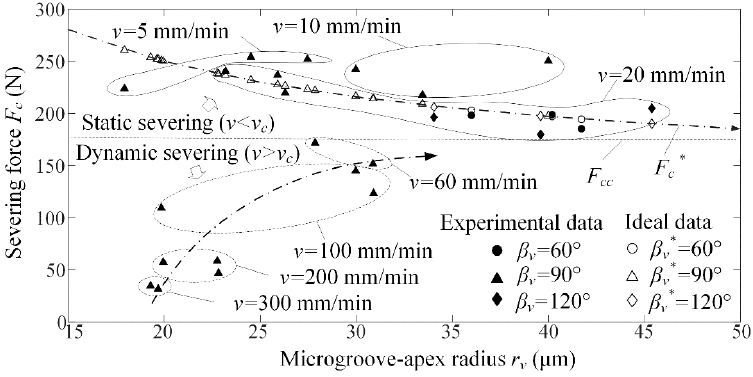
Figure 8. Severing force F c versus microgroove-apex radius r v for different loading rate v and microgroove angle β v .